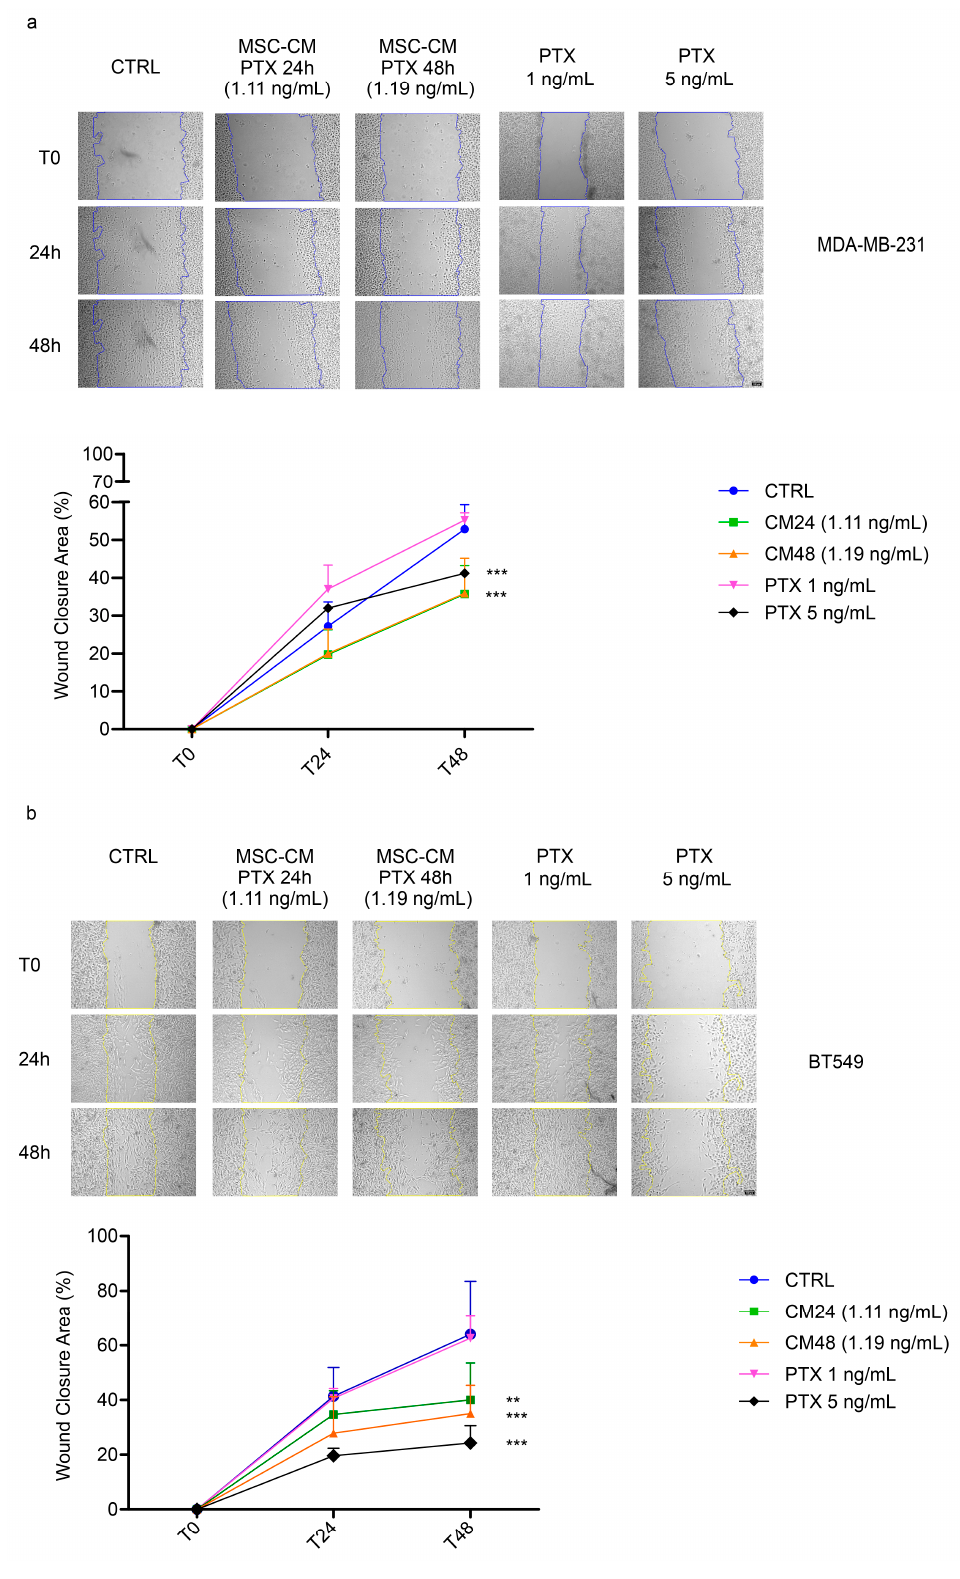
Figure 3. MSC-CM PTX inhibits migration in TNBC cell lines. Scratch wound healing assays in both cell lines, MDA-MB-231 ( a ) and BT549 ( b ), exposed to MSC-CM CTRL, CM PTX 24 h, CM PTX 48 h and free PTX (1 ng/mL and 5 ng/mL). Images were captured at time 0 and after 24 h and 48 h.